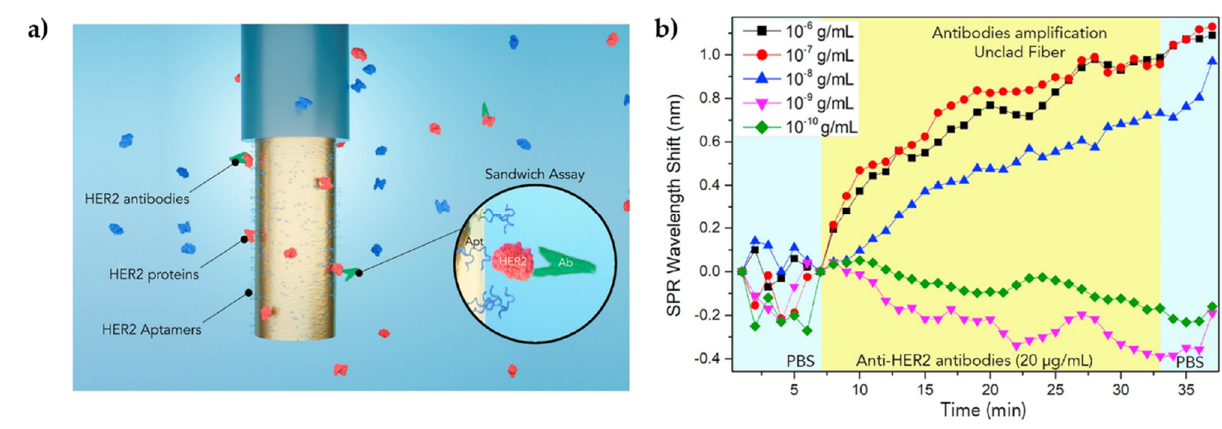
Figure 13. Sandwich assay for detection of the HER2 as cancer biomarker: ( a ) gold-coated unclad fiber functionalized with thiolated aptamers specific to recognize HER2 and further signal amplification using anti-HER2 antibodies; ( b ) SPR wavelength shift as response to HER2 concentration using anti-HER2 antibodies for signal amplification. Reprinted with permission from ref. [44]. Copyright 2021 Elsevier. Biosensors 2021 , 11 , x FOR PEER REVIEW